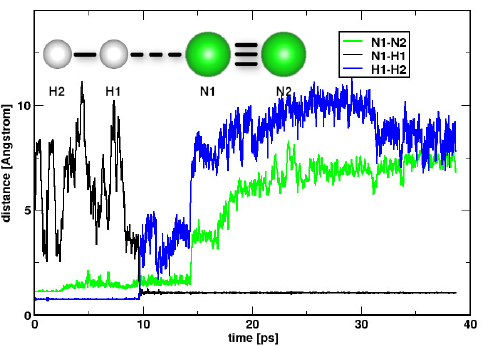
Figure 4. Simulation 10 , first reaction: in the beginning, the N-H bond is formed and the H-H bond is broken. The N-N bond breaks a few picoseconds later.